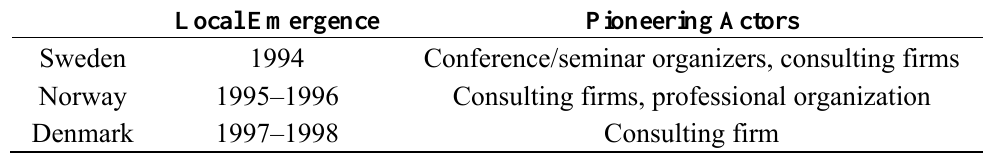
Table 3. The local emergence and pioneering actors (source: [30] (p.